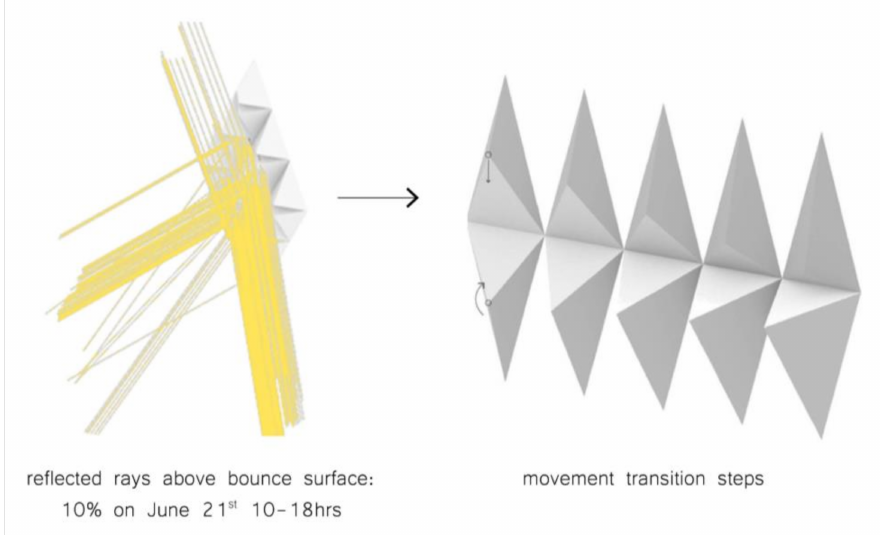
Figure 7. Overview of the various geometry alternatives based on proportions and sizes and a first solar radiation